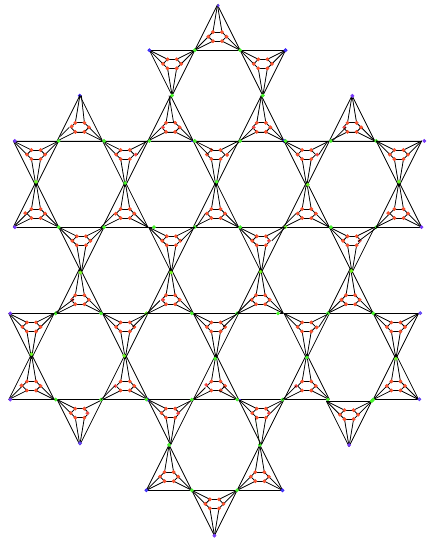
Figure 2. Benzenoid-dominating planar octahedron network BDPOH ( 2 )